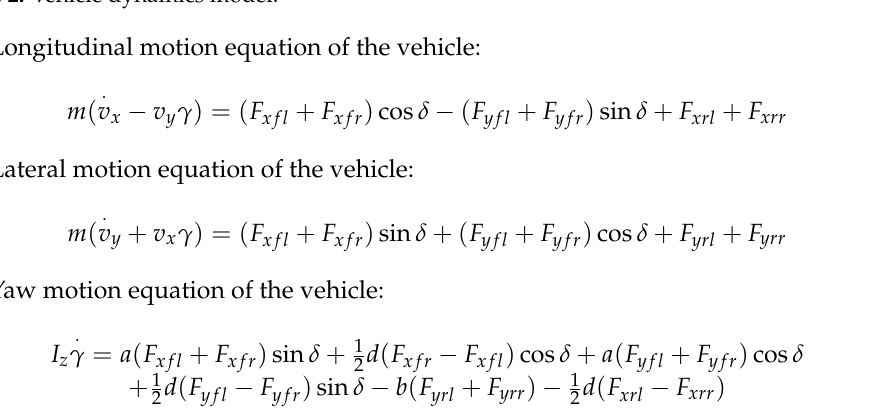
Figure 2. Vehicle dynamics model. Longitudinal motion equation of the vehicle: